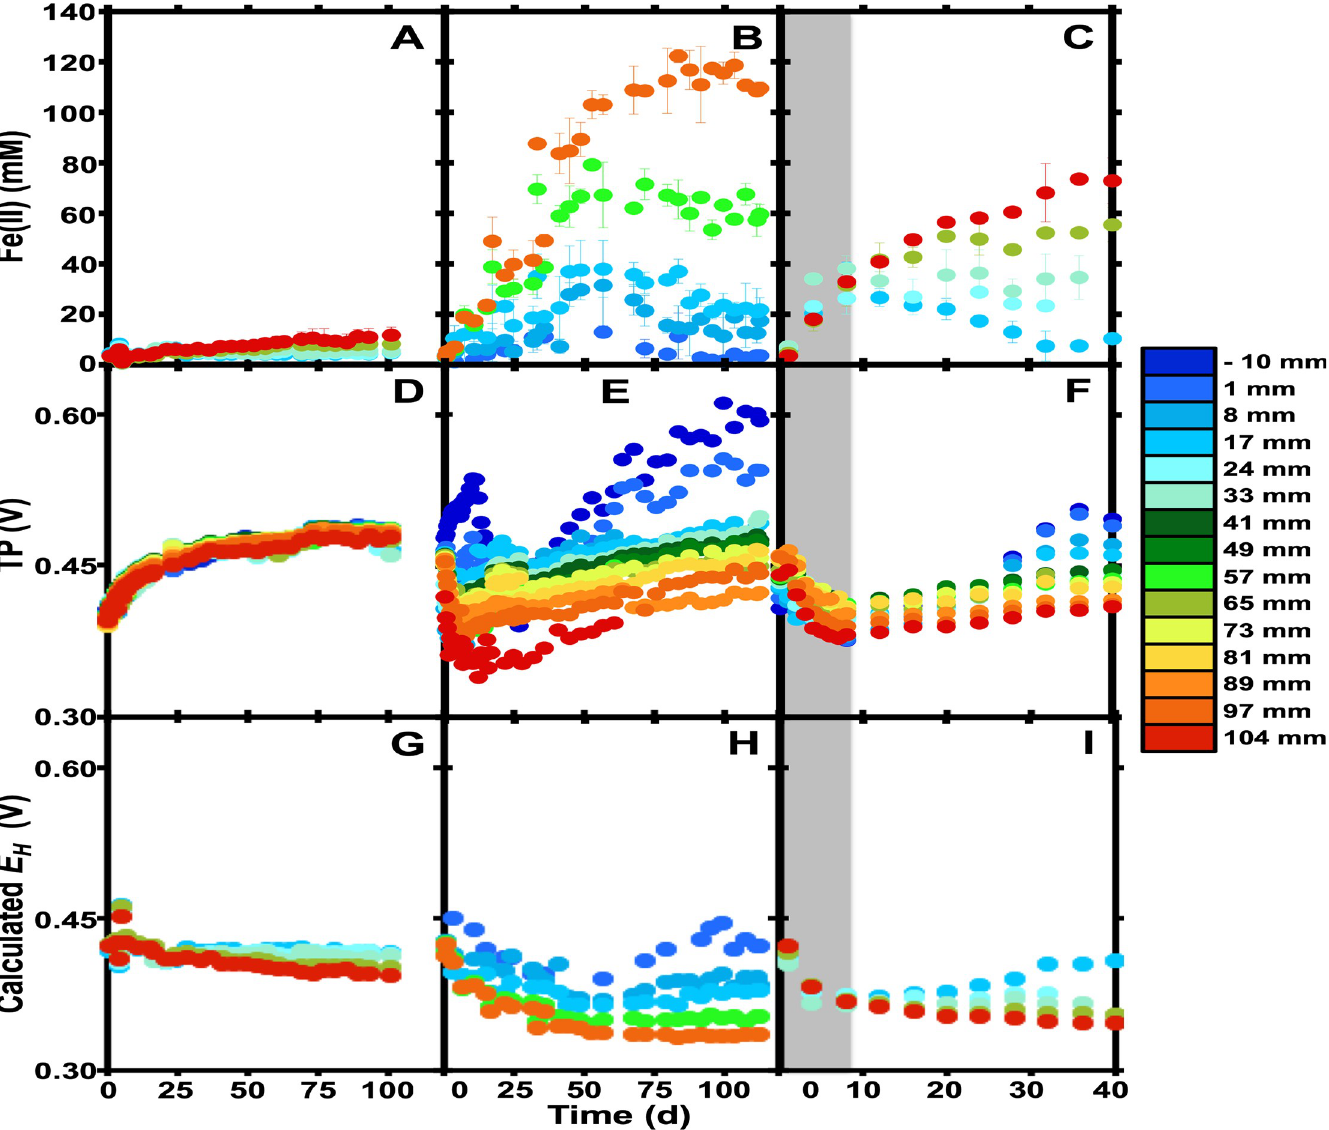
Fig 1. Fe(II) concentrations (A-B), measured total potentials (TP; D-F), and theoretical E H (G-I) at various depths in column incubations containing formaldehyde-deactivated (panels A, D, and G), non-sterile continuously oxic (panels B, E, and H), and non-sterile, initially anoxic (panels C, F, and I) iron mound sediments. Depths represent the midpoint of a depth interval of 5 mm, with the sediment-water interface at 0 mm. Gray shading in panels C, F, and I represents the time period during which the headspace of column incubations was N 2 (with air subsequently allowed into the incubations). As a guide, cooler colors represent measurements in shallower portions of the columns, while warmer colors represent deeper portions. Error bars represent one standard deviation.